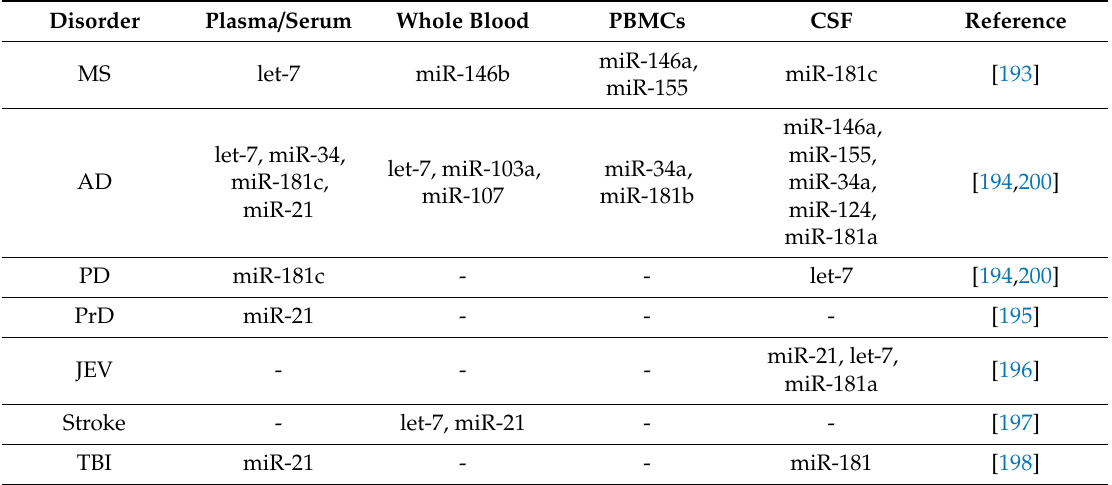
Table 2. Inflammatory miRNAs identified as non-invasive biomarkers of neuroinflammatory disorders.